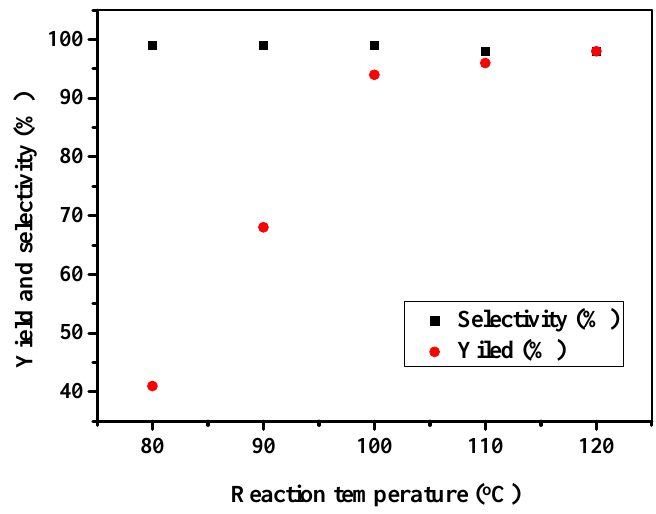
Figure 3. Influence of reaction temperature on the cycloaddition reaction. Reaction conditions: PO 34.5 mmol, GndCl 1.0 mmol, ZnI 2 0.2 mmol, CO 2 pressure 1.0 MPa, 1.5 h.